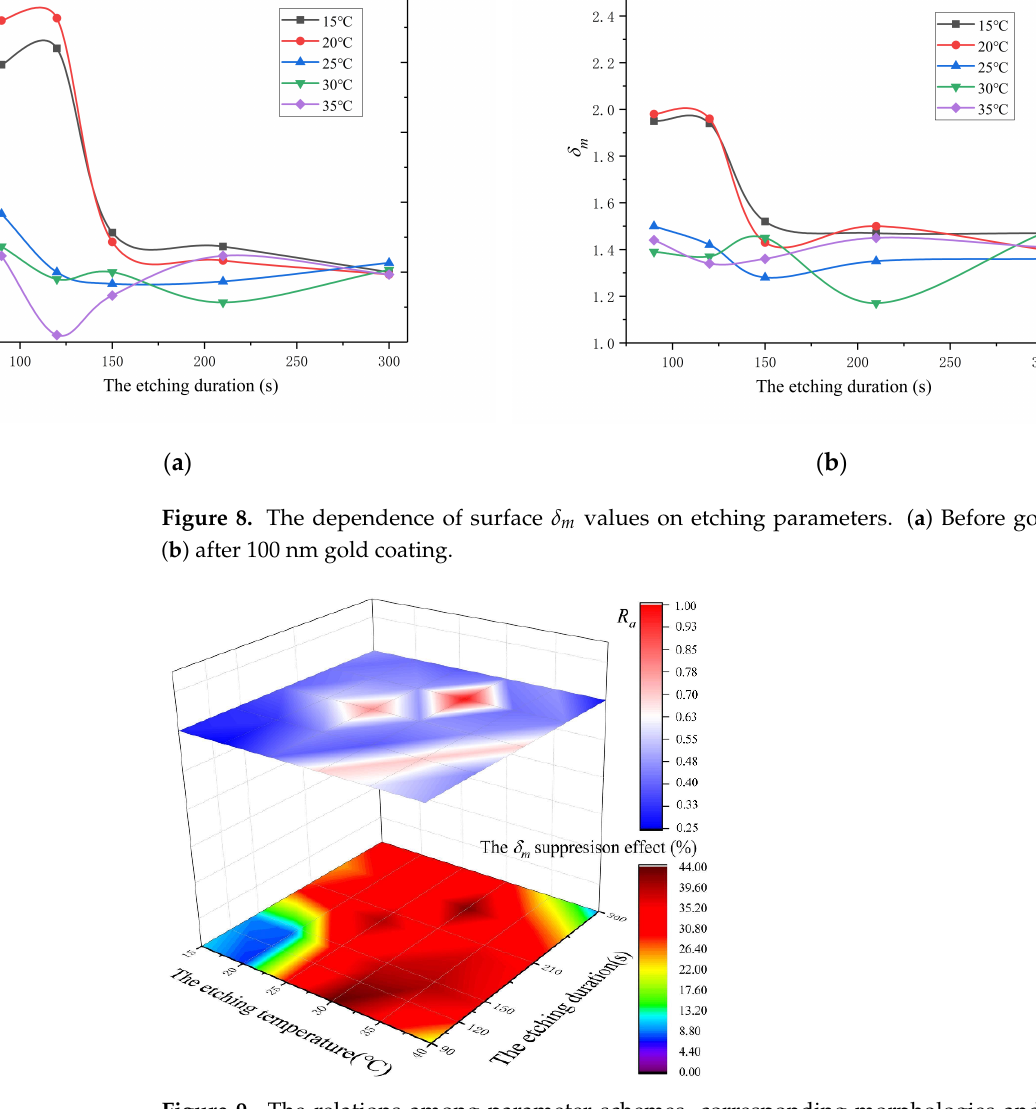
Figure 8. The dependence of surface 𝛿 (cid:3040) values on etching parameters. ( a ) Before gold coating; ( b ) after 100 nm gold coating.